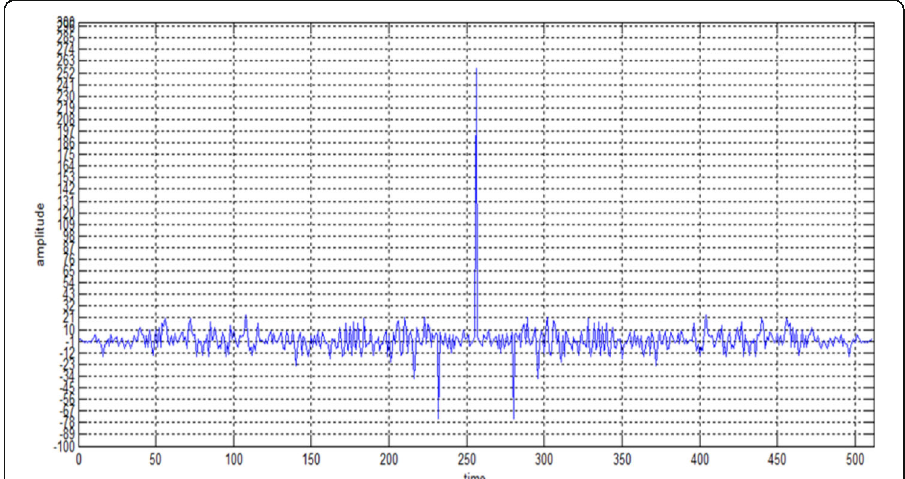
Fig. 13 Autocorrelation function of f C